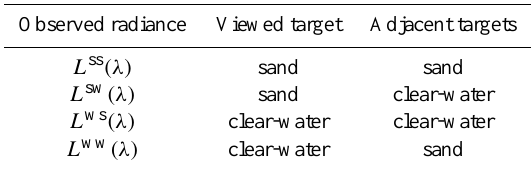
Table 2. The observed radiance simulated using sand (representa- tive for bright) and water (representative for dark) for viewed and adjacent